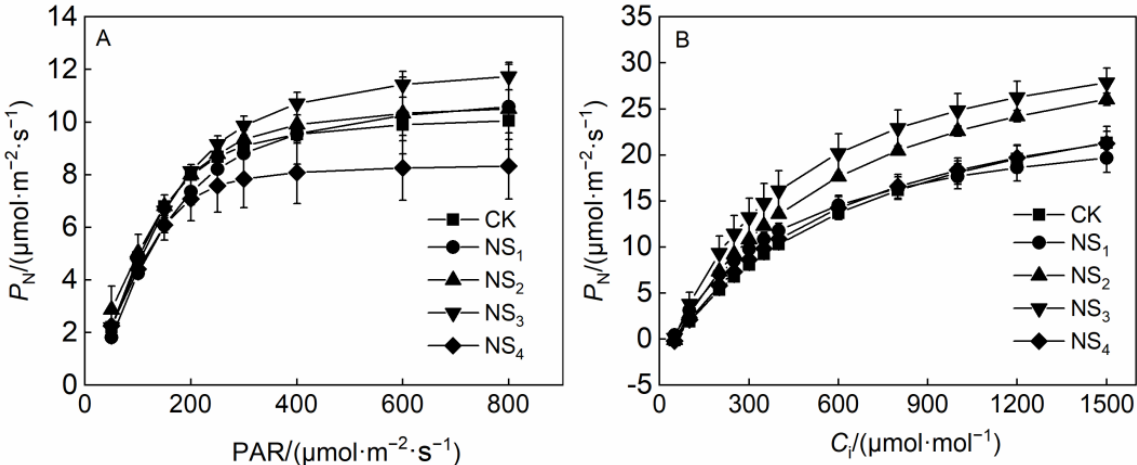
Figure 2. Net photosynthetic rate ( P N ) − photosynthetically active radiation (PAR) curve ( A ) and net photosynthetic rate-intercellular carbon dioxide ( C i ) curve ( B ) of O. violaceus under different concentrations of NaHSO 3 . Values are the means ± SE. Symbols with different letters show significant differences at p < 0.05 (Duncan).